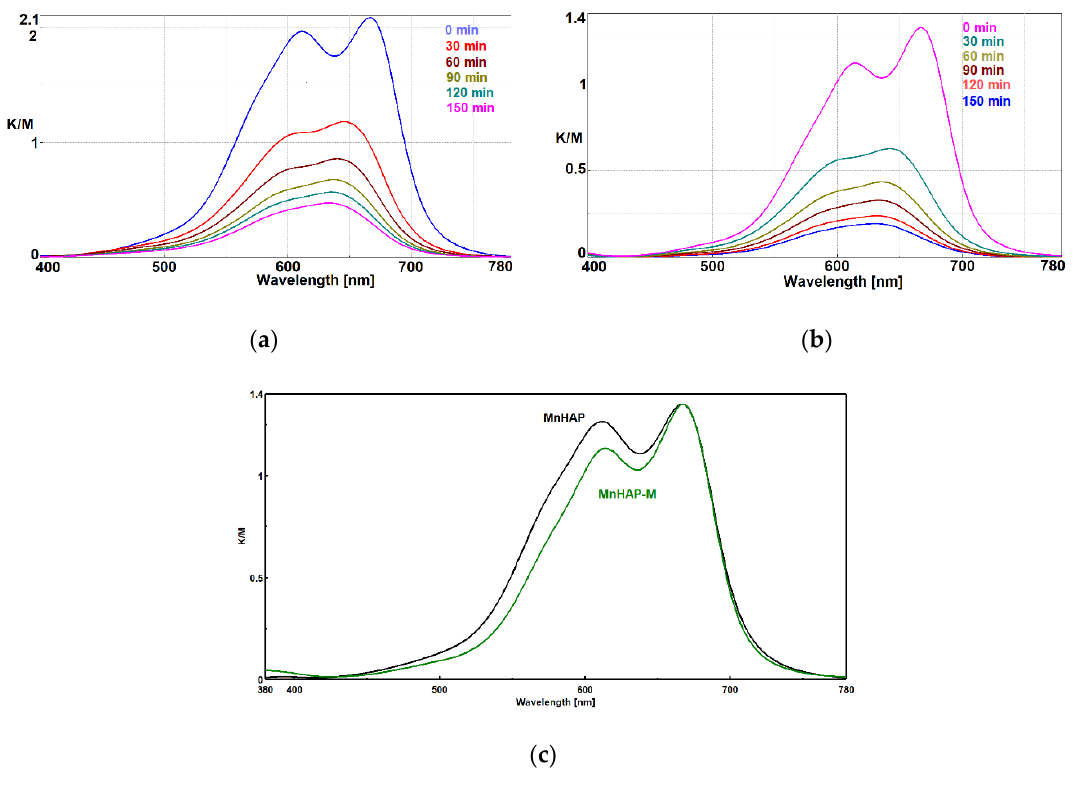
Figure 6. Photodecomposition of MB using coatings containing HAP-Mn ( a ) and HAP-Mn-M ( b ) at 0, 30, 60, 90, 120, and 150 min.; normalized Kubelka – Munk spectra for the two used materials ( c ).